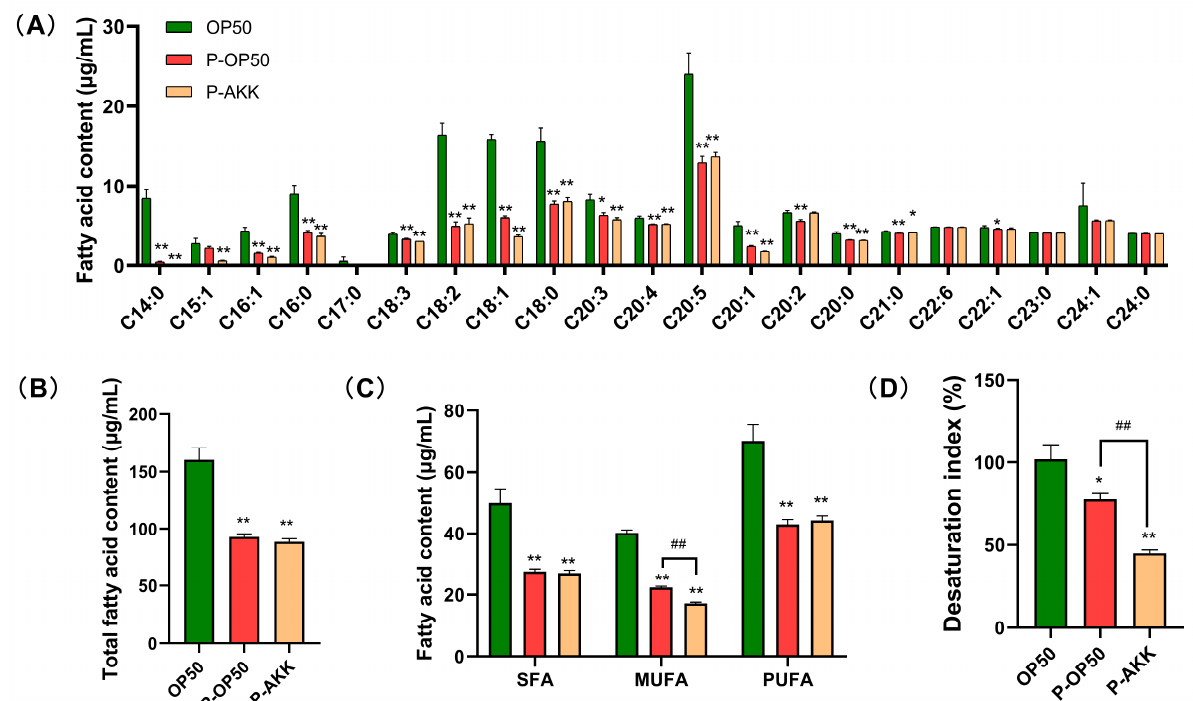
Figure 4. Decrease in the proportion of MUFAs by p-AKK treatment. ( A ) Total fatty acid profiles of C. elegans treated with different bacteria analyzed using GC-MS (N = 3). The contents of each fatty acid were calculated. ( B ) The contents of total fatty acids in each group of nematodes were calculated (N = 3). ( C ) SFA, MUFA and PUFA levels in worms fed different bacteria (N = 3). ( D ) The desaturation index of fatty acid in each group were calculated (N = 3). Error bars represent SD. Using an independent sample t -test, statistically significant differences and extremely significant differences were defined as (*) p < 0.05 and (**) p < 0.01 compared to the OP50 group, respectively. ( ## ) p < 0.01 compared to the p-OP50 group.